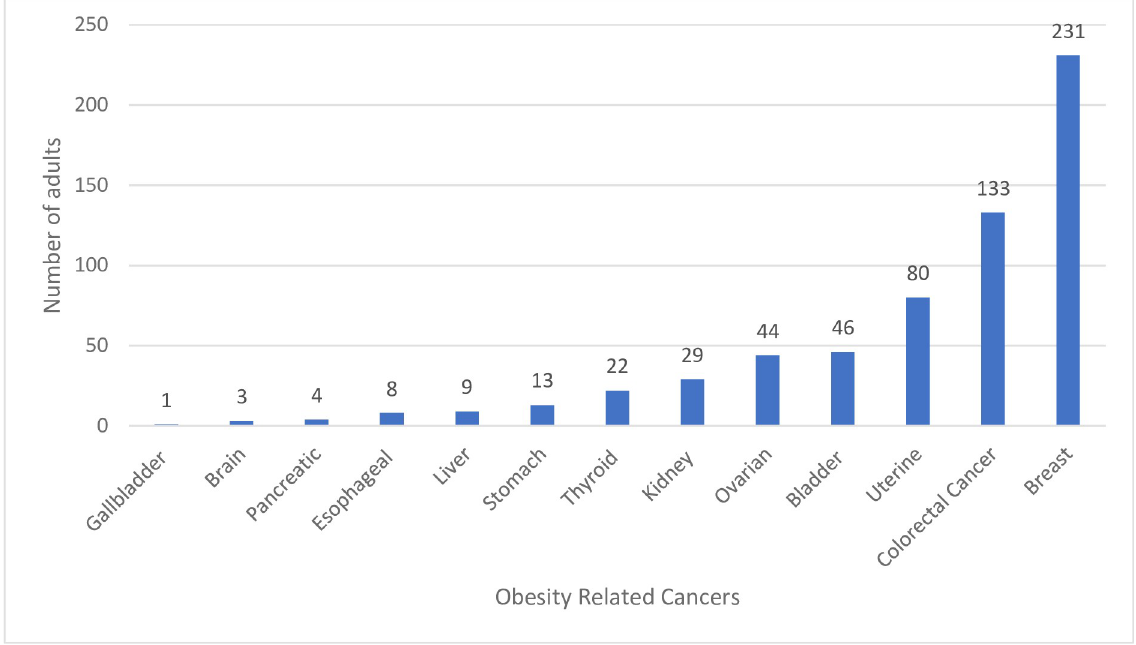
Fig 1. Prevalence of specific obesity-related cancers. The most common were breast (14.6%), colorectal (6.6%), and uterine (4.3%)